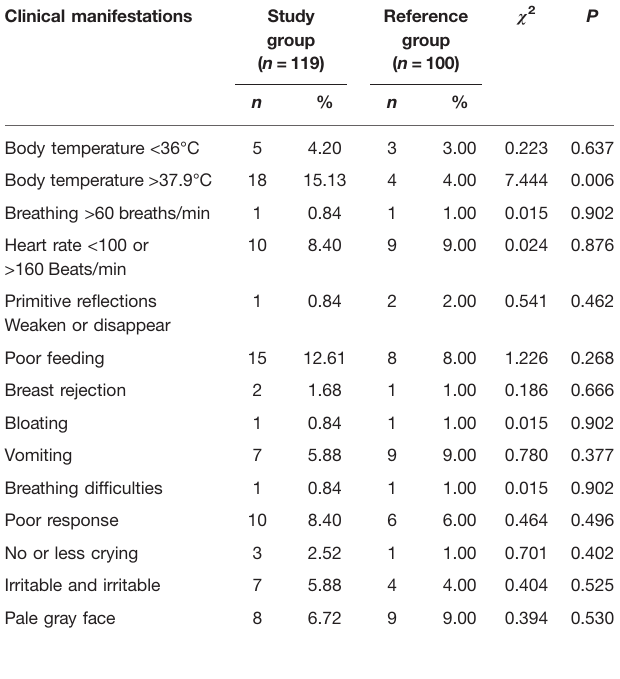
TABLE 2 | Multifactorial analysis of EONBI and obstetric high-risk factors. High-risk